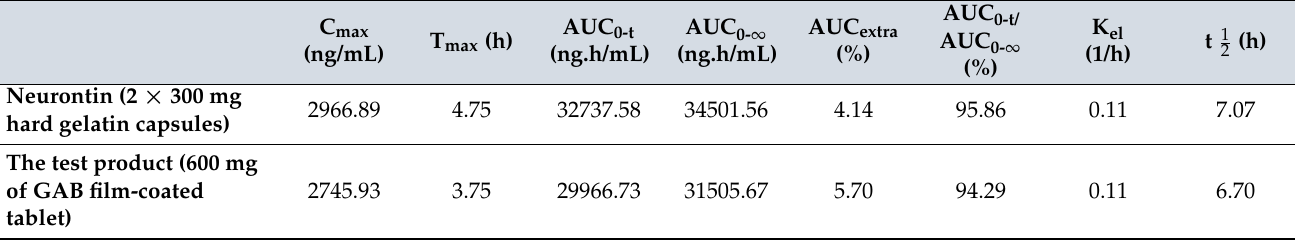
Table 6. Pharmacokinetic parameters of GAB in human plasma following a single oral administration of two different dosage